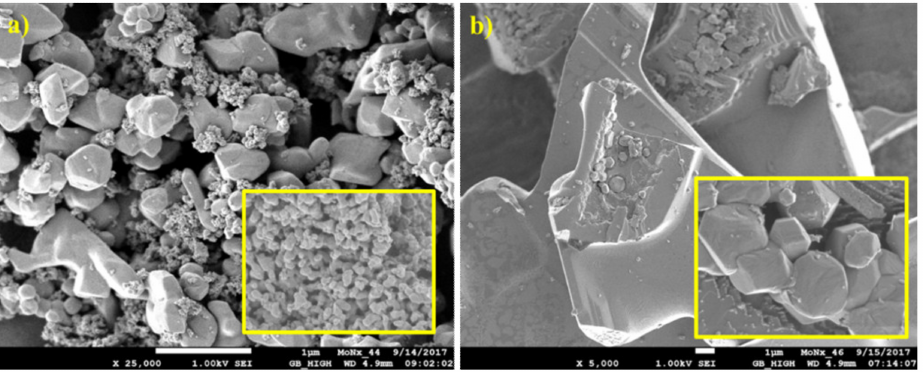
Figure 14. SEM images of ( a ) HMT+AHM-S (1:1) and ( b ) MoO3 prepared at 700 ◦ C (magnifications of 25,000 × and 100,000 ×